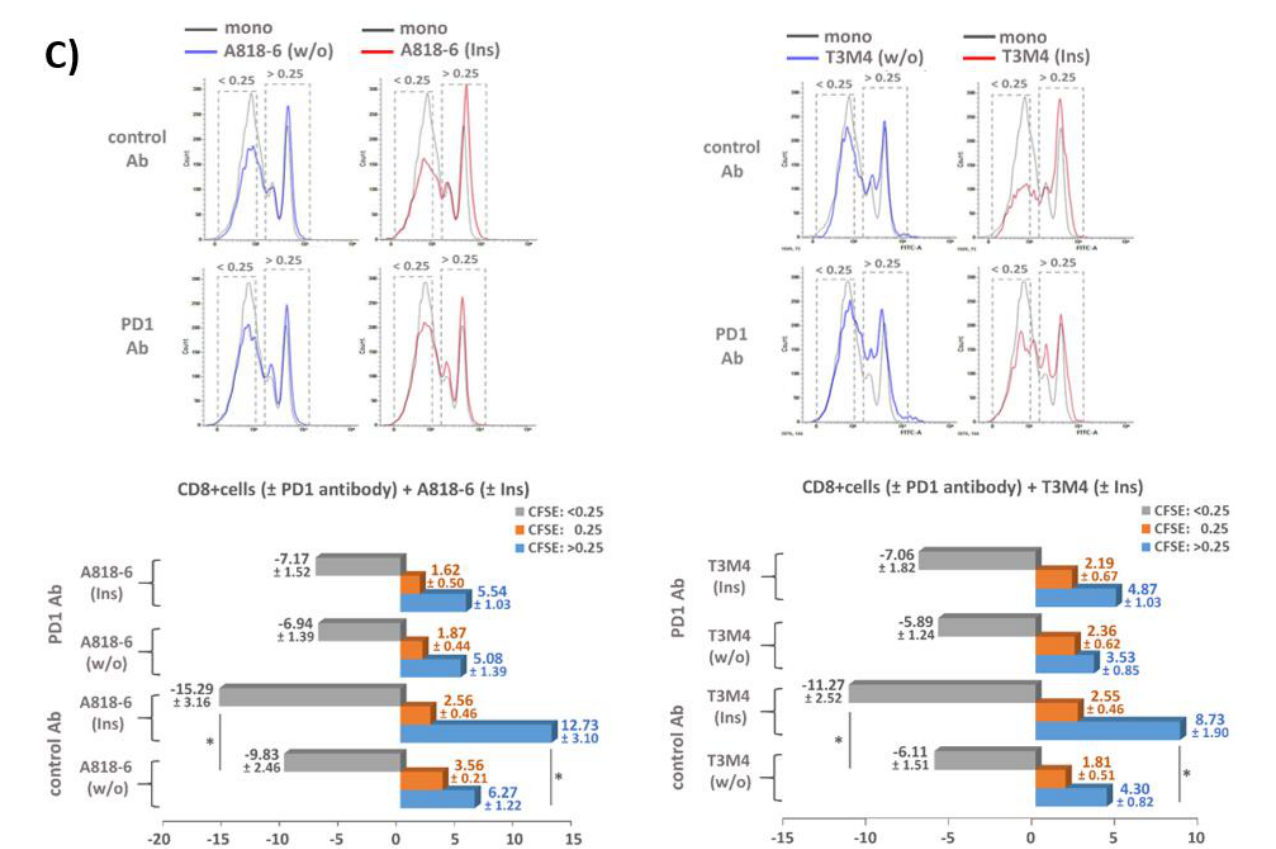
Figure 7. Insulin-induced PD-L1 expression in PDAC cells suppresses proliferative activity of CD8+ T-cells. ( A ) 1 × 10 5 serum-starved A818-6 and T3M4 cells were left untreated (w/o) or treated with 0.1 IU/mL insulin (Ins) for 24 h. Then, cells were cocultured with 250,000 CFSE labelled and preactivated human CD8+ T-cells. At a final FCS concentration of 1% ( v / v ), PDAC and CD8+ T-cells were cocultured for 72 h. In parallel, CD8+ T-cells were monocultured under the same conditions. Afterwards, CD8+ T-cells were collected and submitted to flow cytometry for quantification of CFSE staining intensity. ( B ) A818-6 and T3M4 cells were pretreated with control or PD-L1 siRNA for 24 h, followed by serum starvation and subsequent treatment with 0.1 IU/mL insulin (Ins) or without (w/o) for 24 h. Then, CD8+ T-cells co/monoculture and flow cytometry for quantification of CFSE staining intensity were performed as described above. ( C ) Serum-starved A818-6 and T3M4 cells were left untreated or treated with 0.1 IU/mL insulin for 24 h. Then, the PDAC cells were cocultured with CFSE labelled and preactivated human CD8+ T-cells pretreated for 1 h with 2.5 µg/mL of PD-1 antibody (Pembrolizumab) or control antibody (Human IgG4, kappa). CD8+ T-cells co/monoculture and flow cytometry for quantification of CFSE staining intensity were performed as above. ( A – C ) The bar diagrams represent the percent decrease (−%) or increase (+%) of the three CFSE staining intensity fractions (<0.25, 0.25, >0.25) compared to monocultured CD8+ T-cells. The intensity fractions are highlighted by the dashed boxes in the representative histograms depicted in the upper panels. Data represent the mean ± SD from four ( A , B ) and five ( C ) independent experiments, respectively, performed in duplicates; (* p < 0.05 compared to untreated).